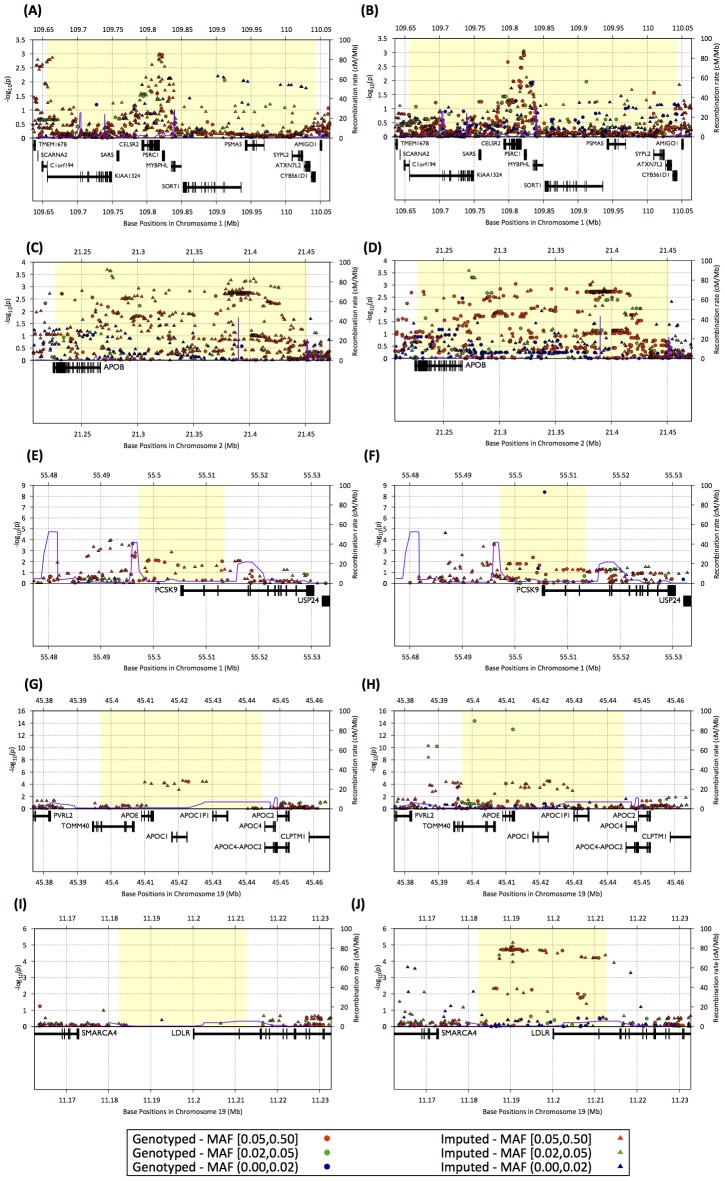
Regional association plots for LDL cholesterol association in the SardiNIA study.Association plots for a study of 2,432 Sardinian individuals for five Metabochip fine-mapping regions using 1000 Genomes data as reference set and Affymetrix genotypes (left panels : A,C,E,G,H) or Metabochip genotypes (right panels : B,D,F,H,J) as target sets. The figures plot −log10 of the association p-value within the region and recombination rate (blue lines) as a function of position on the chromosome. Blue, green, and red dots and triangles indicate genotyped and imputed SNPs with minor allele frequencies less than 0.02, greater than or equal 0.02 and less than 0.05, and greater than or equal 0.05, respectively. Gene positions and structures are displayed in the lower panel.